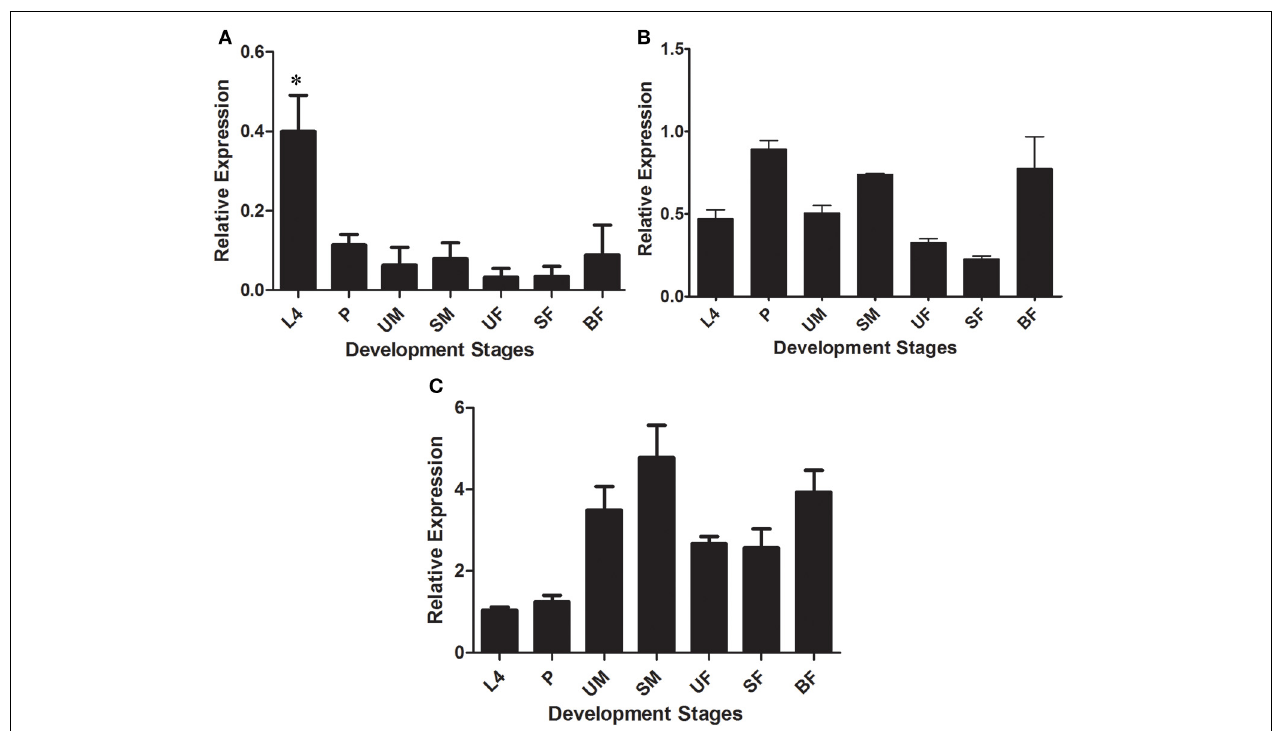
FIGURE 4 | Relative expression of β -1,3-glucanases (Ll β Glu) (A) and β -glucan binding proteins (LlGBP1 and LlGBP2) (B,C, respectively) in different stages of development of Lutzomyia longipalpis as determined by Multiplex RT-PCR (Ribosomal protein 60 used as constitutive gene). The experimental groups used in the experiments were larvae (L4), pupae